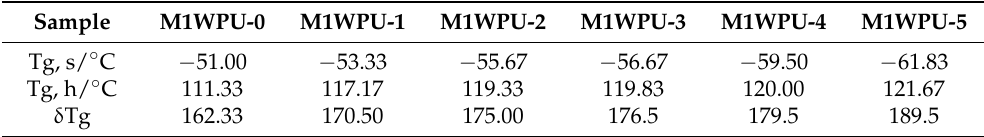
Table 4. Glass transition temperatures for M1WPU-1 to